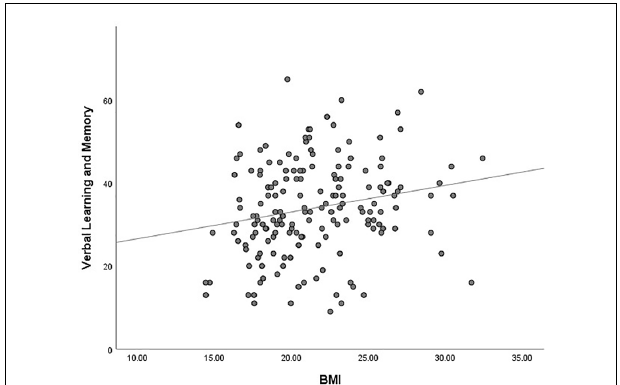
FIGURE 1 | MATRICS Consensus Cognitive Battery (MCCB) verbal learning and memory score was positively associated with body mass index (BMI) of the total number of study patients ( p = 0.007).